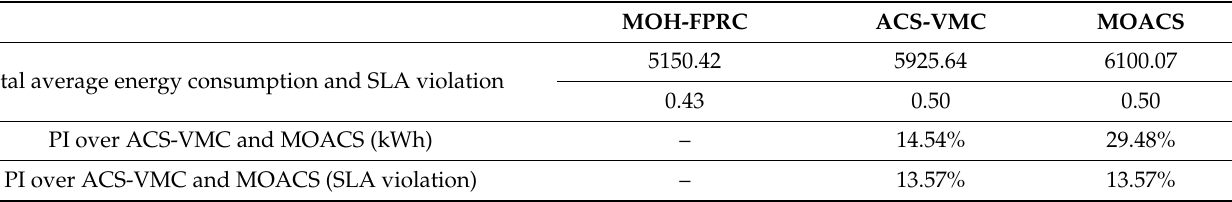
Table 5. Average energy consumption and SLA violation with different number of PMs.